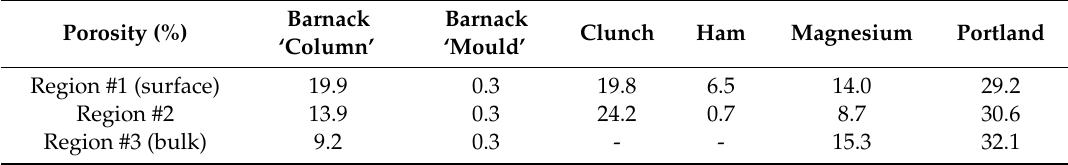
Table 2. Stone porosities (%) calculated after 12 weeks from the treatment, using black-to-white binarisation of polished stone cross-sectional images using